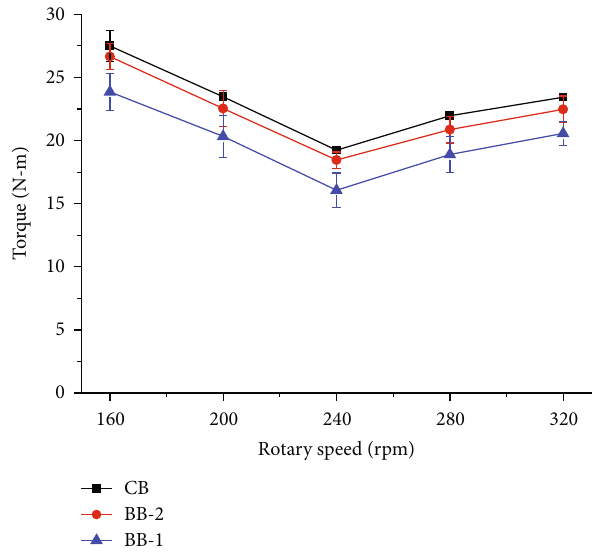
Figure 13: The torques of the three rotary tillage blades a ff ected by rotary